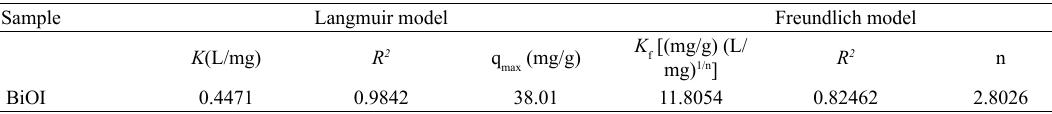
Table 4. Isotherm parameters for the adsorption of Cr(VI) onto BiOI sample